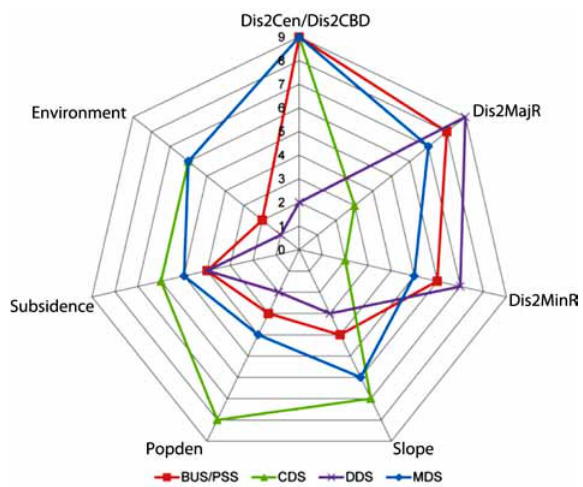
Fig. 9. Relative importance of the factors for each scenario